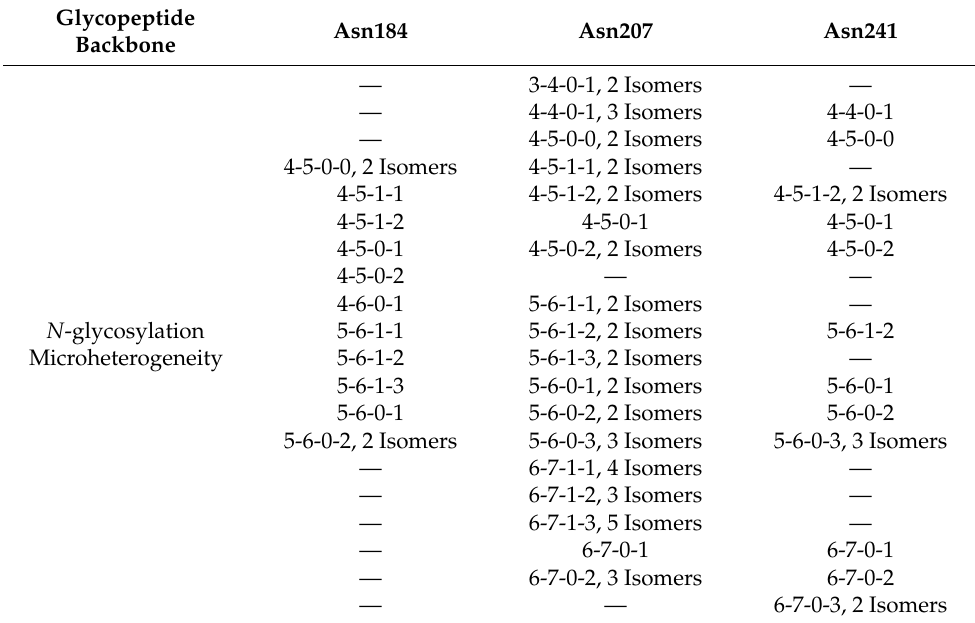
Table 1. Serum haptoglobin microheterogeneity, N -glycopeptide structures by glycosylation site including isomeric forms. MVSHHN184LTTGATLINE = Asn184, NLFLN207HSE = Asn207, and VVLHPN241YSQVDIGLIK = Asn241. Glycan nomenclature; HexNAc, Hex, Fuc,